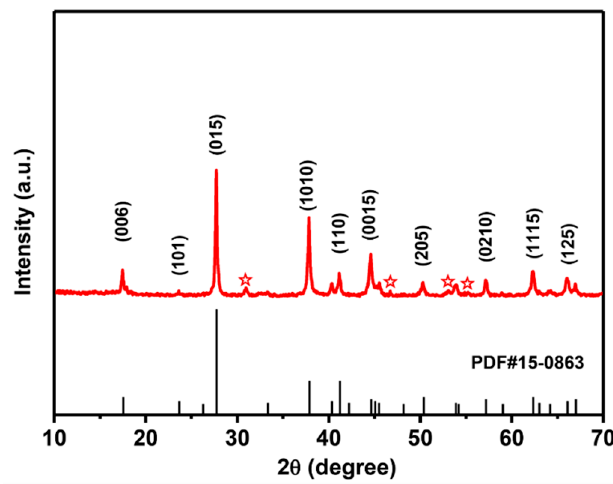
Figure 5. XRD patterns of the rGO/Bi 2 Te 3 nanocomposite bulk material with 0.25 wt% rGO.